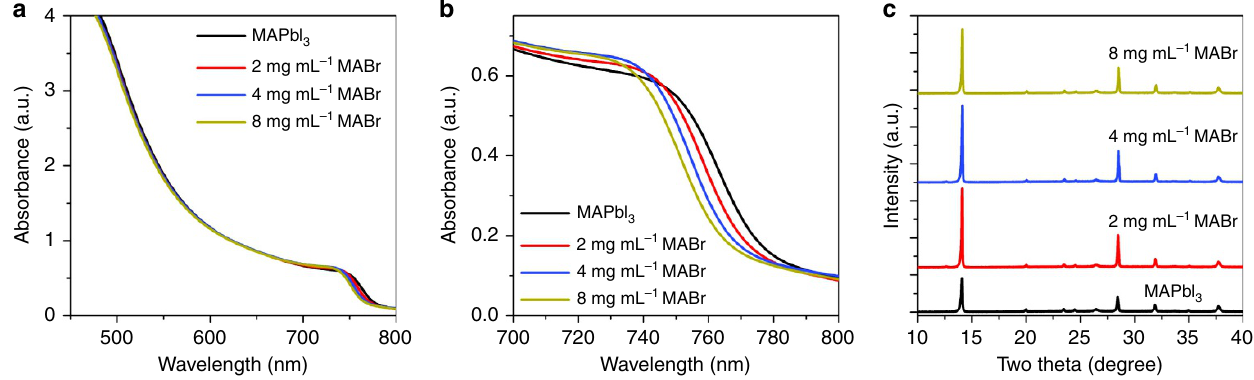
Figure 4 | MABr concentration effect on absorption and structure of MAPbI 3 thin films. ( a ) UV-vis absorption spectra with ( b ) a zoom-in view near the absorption edge, and ( c ) X-ray diffraction patterns of the high-quality MAPbI 3 thin films without and with MABr treatment at different concentrations, as